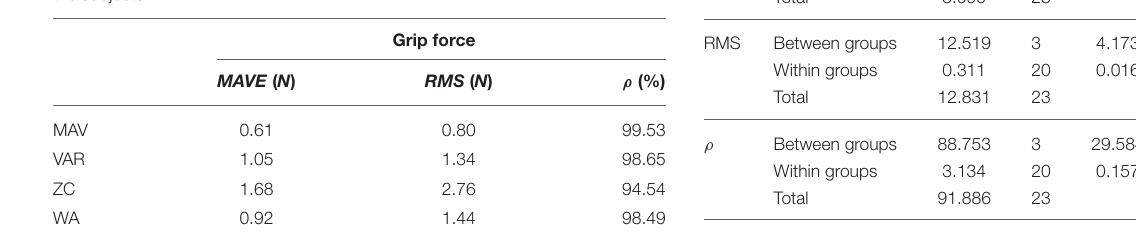
df Sum of squares